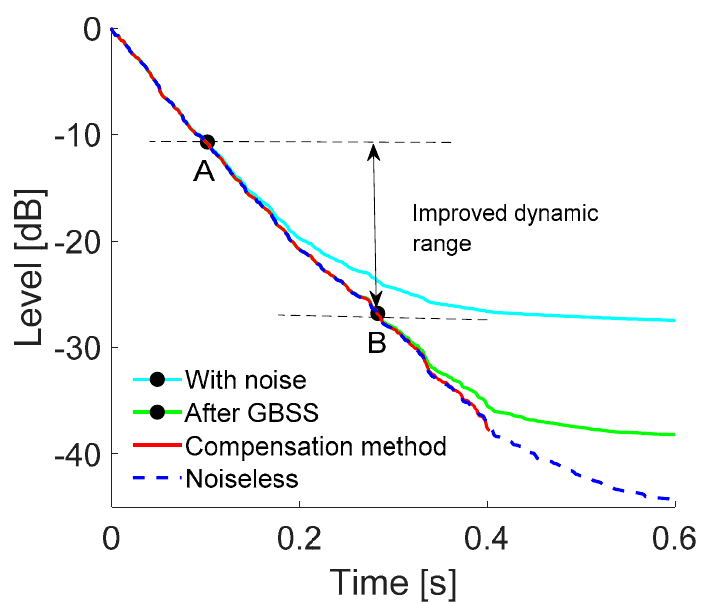
Figure 1. Dynamic range improvement of the EDC between cross-point A at a noisy RIR and cross-point B at RIR after the GBSS.